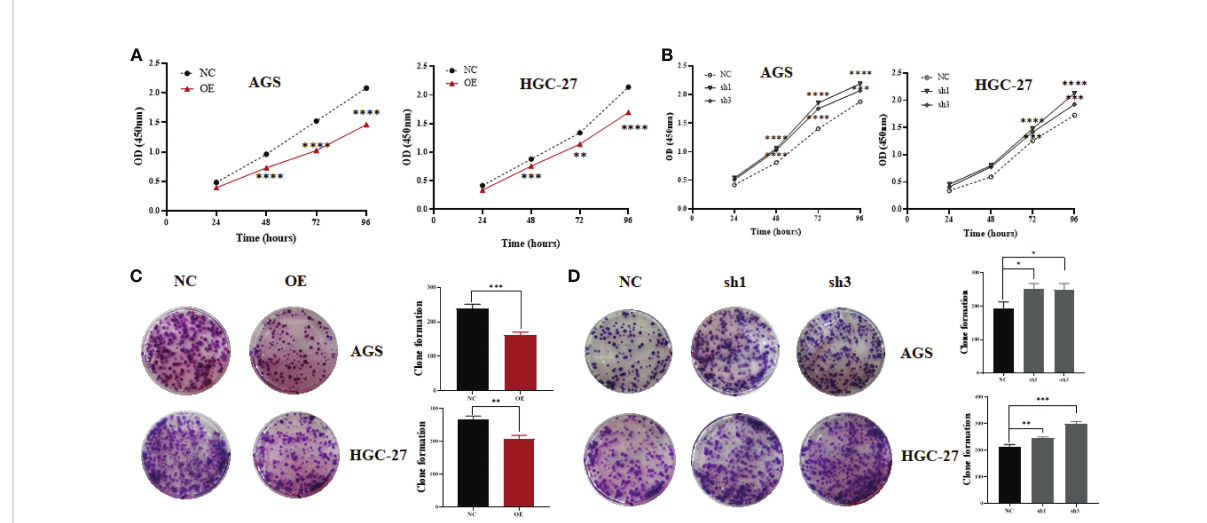
FIGURE 1 Proliferation of gastric cancer cells after upregulating or downregulating the expression of hsa_circ_0061276. (A) Growth curve of AGS and HGC-27 cells after upregulating hsa_circ_0061276; OE, overexpression plasmid; NC, negative control plasmid. ** p < 0.01, *** p < 0.001, **** p < 0.0001; n = 3. (B) Growth curve of AGS and HGC-27 cells after downregulation of hsa_circ_0061276; NC, negative control plasmid; sh1 and sh3, short hairpin RNA plasmids. ** p < 0.01, *** p < 0.001, **** p < 0.0001; n = 3. (C) Representative clones of gastric cancer cells after upregulating hsa_circ_0061276 (left) and the statistical analysis results (right). OE, overexpression plasmid; NC, negative control plasmid. ** p < 0.01, *** p < 0.001; n = 3. (D) Representative clones of gastric cancer cells after downregulating hsa_circ_0061276 (left) and the statistical analysis results (right). NC, negative control plasmid; sh1 and sh3, short hairpin RNA plasmids; * p < 0.05, ** p < 0.01, *** p < 0.001; n = 3. Independent samples t -test (two-tailed) for